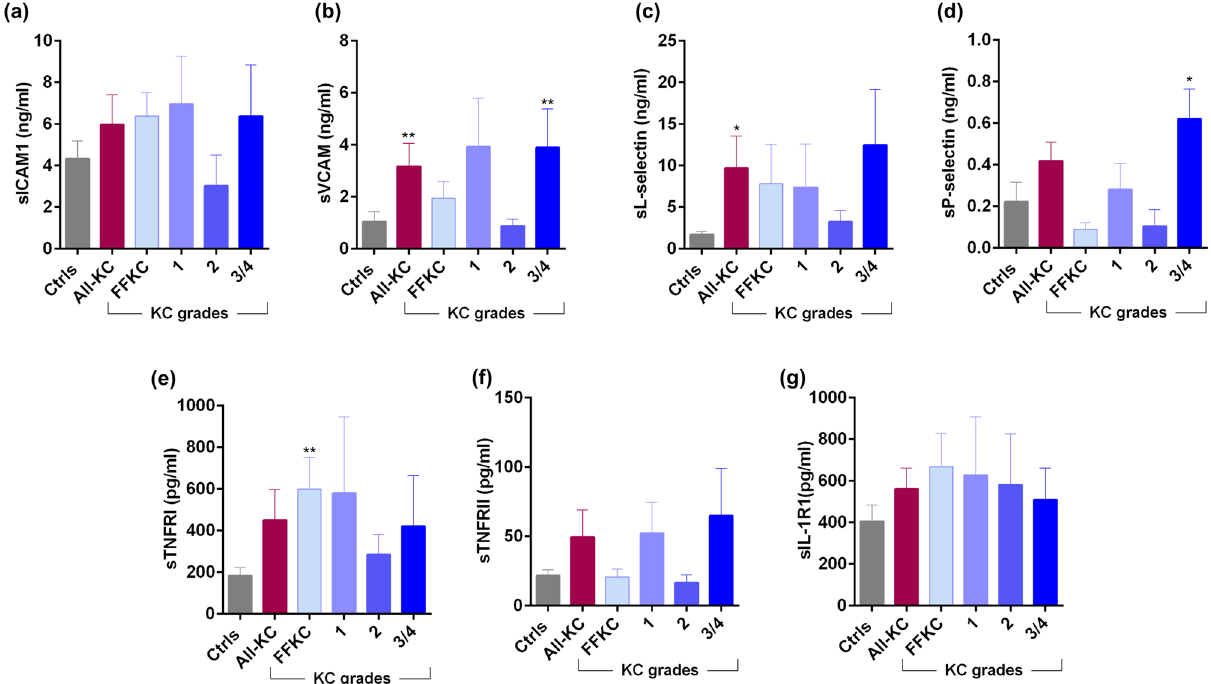
Figure 6. Tear fluid soluble cell adhesion molecules and soluble receptors level in KC patients: The graphs indicate the concentration of sICAM1 ( a ), sVCAM ( b ), sL-selectin ( c ), sP-selectin ( d ), sTNFRI ( e ), sTNFRII ( f ) and sIL-1R1 ( g ) in the tear fluid of subjects with different grades of KC. Ctrls—Controls; All-KC—all the grades of keratoconus combined; FFKC—Forme fruste keratoconus; sICAM1—Intercellular Adhesion Molecule 1; sVCAM—vascular cell adhesion molecule; sTNFRI—soluble tumor necrosis factor receptor 1; sTNFRII— soluble tumor necrosis factor receptor II; sIL-1R1—soluble interleukin 1 receptor type ISEM—standard error of the mean; Controls (20 eyes), All-KC (41 eyes), FFKC (6 eyes), grade 1 KC (6 eyes), grade 2 KC (6 eyes), grade 3 or 4 (23 eyes); Bar graphs represent Mean ± SEM; *P < 0.05, **P < 0.01,***P < 0.001, ****P < 0.0001, Mann– Whitney